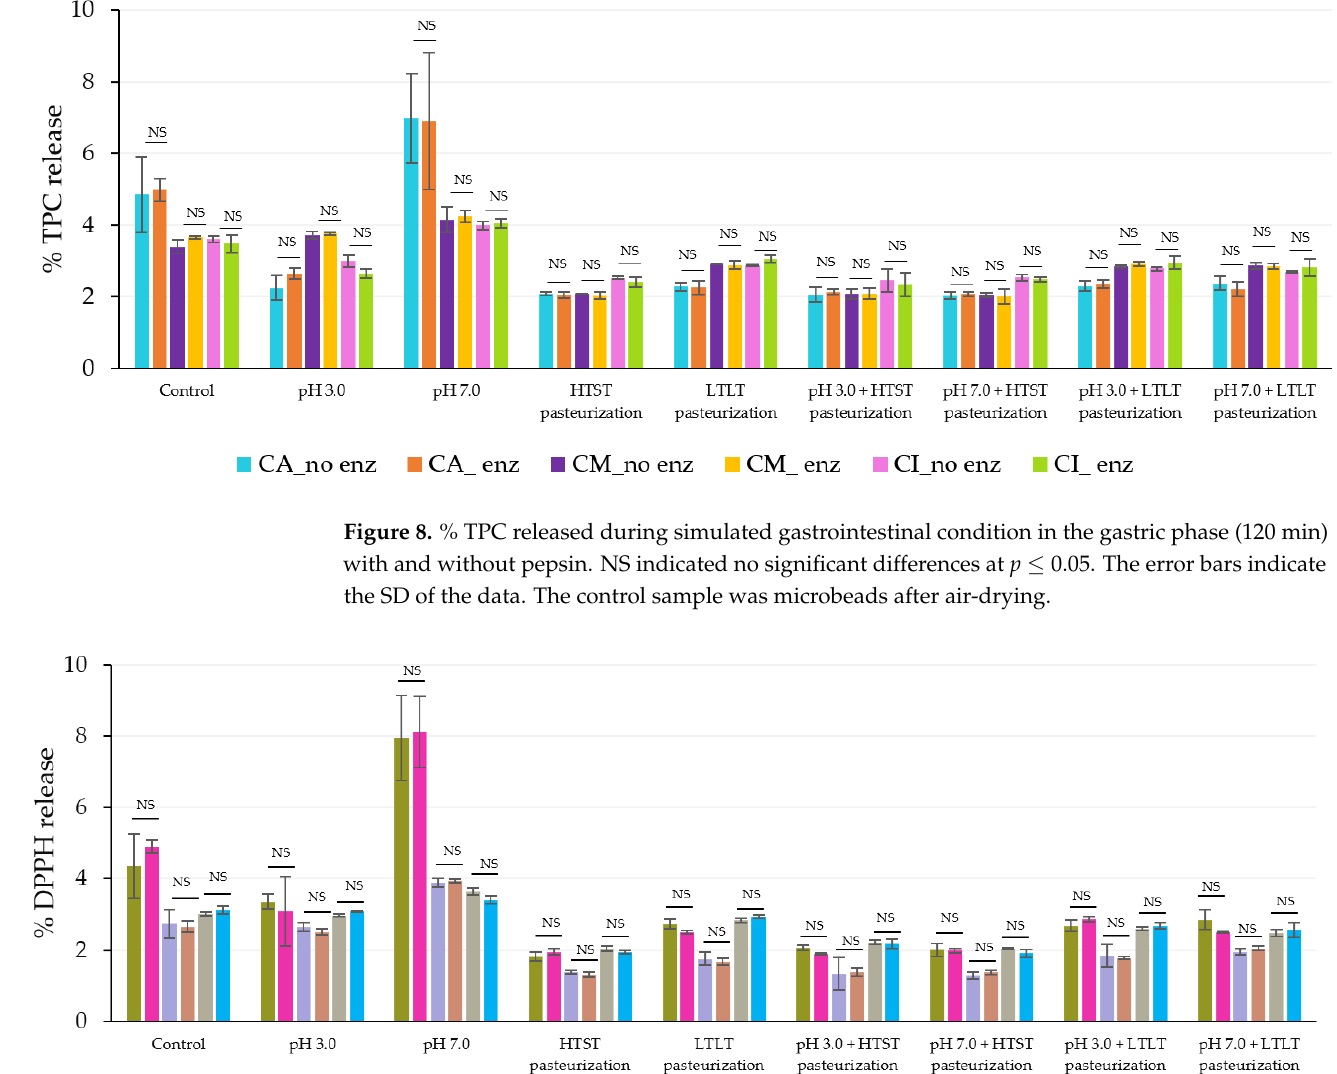
Figure 7. % DPPH released during simulated gastrointestinal conditions in the oral phase with and without salivary amylase. NS indicated no significant differences at p ≤ 0.05. The error bars indicate the SD of the data. The control sample was microbeads after air-drying.